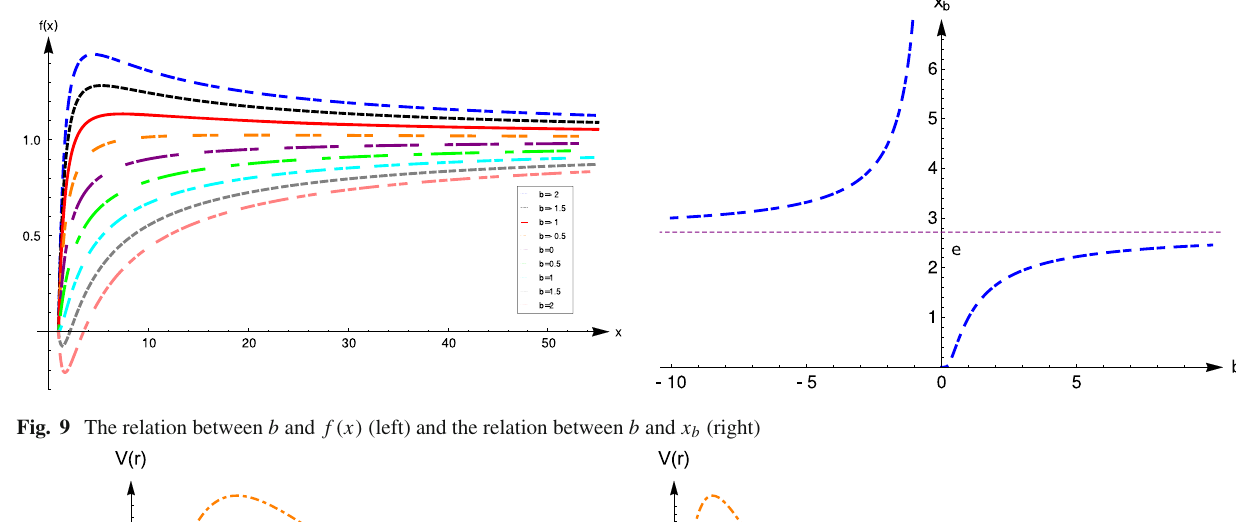
Fig. 9 The relation between b and f ( x ) (left) and the relation between b and x b (right)